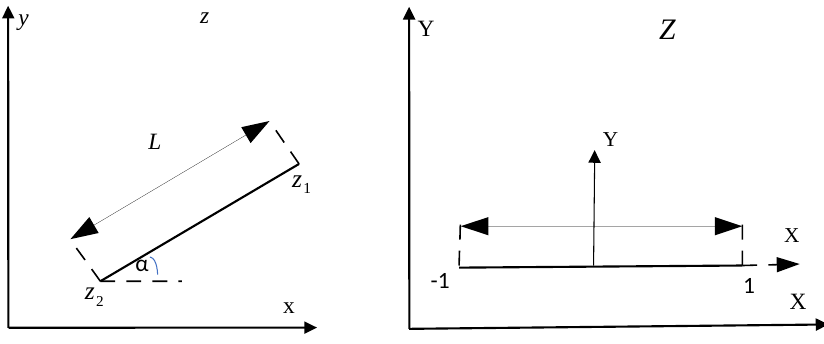
Figure 1. Transformation of z from global to local coordinates